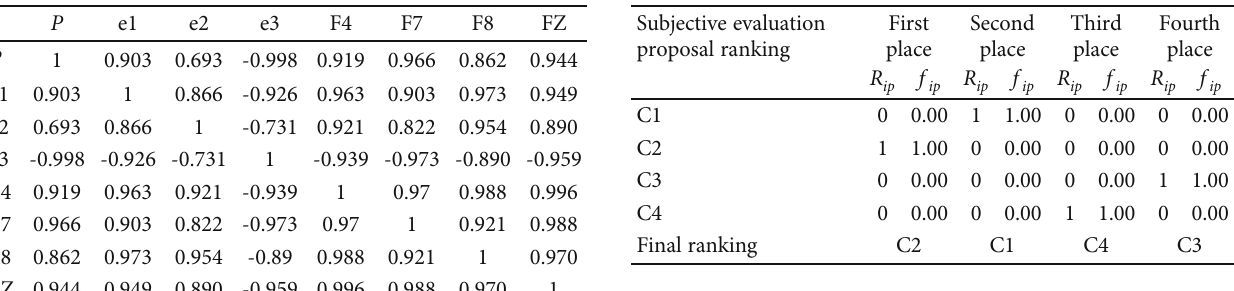
Table 1: Correlation analysis data 1.